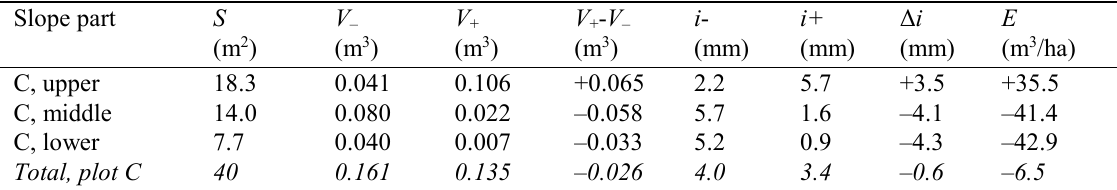
Table 1 Results of data processing April–June 2012 (Plot